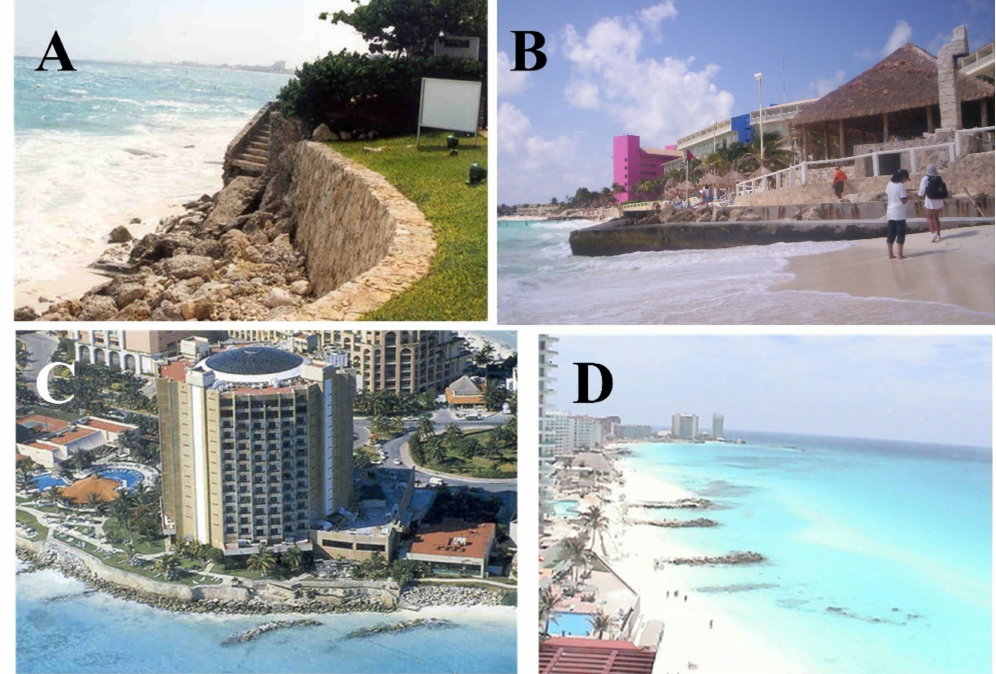
Figure 3. Examples of inadequate solutions implemented 1988–2004. Vertical walls (panels A and B ); detached structures (panel C ) and groins (panel D